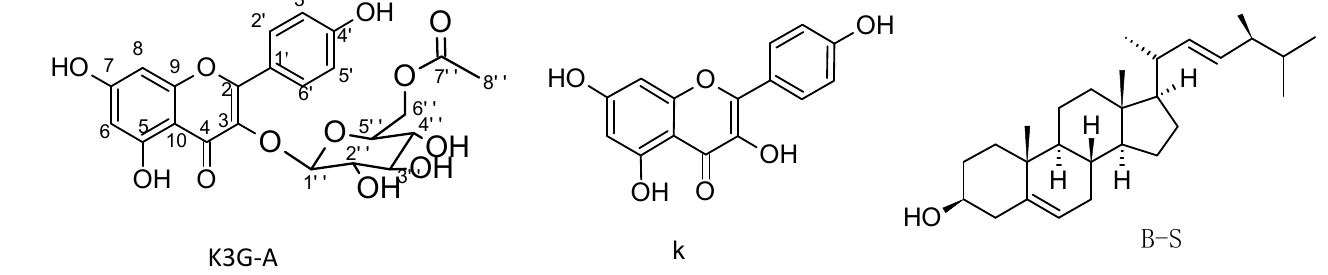
Figure 1. The isolated compounds. Table 1. 1 H and 13 C spectral data of K3G-A (DMSO).